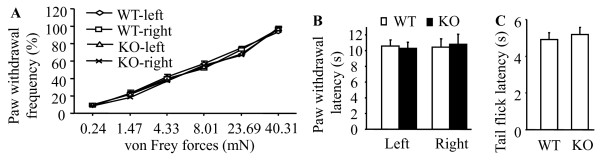
PICK1 knockout (KO) preserves acute pain. A, Baseline paw withdrawal frequencies in response to various forces of von Frey monofilaments in naïve wild-type (WT) and PICK1 KO mice. B, Baseline paw withdrawal latencies in response to heat stimulation in naïve WT and PICK1 KO mice. C, Baseline tail-flick latencies in response to heat stimulation in naïve WT and PICK1 KO mice.